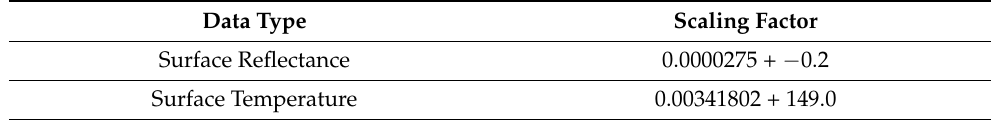
Table 2. Scaling Factor of Level-2 Landsat-8 images